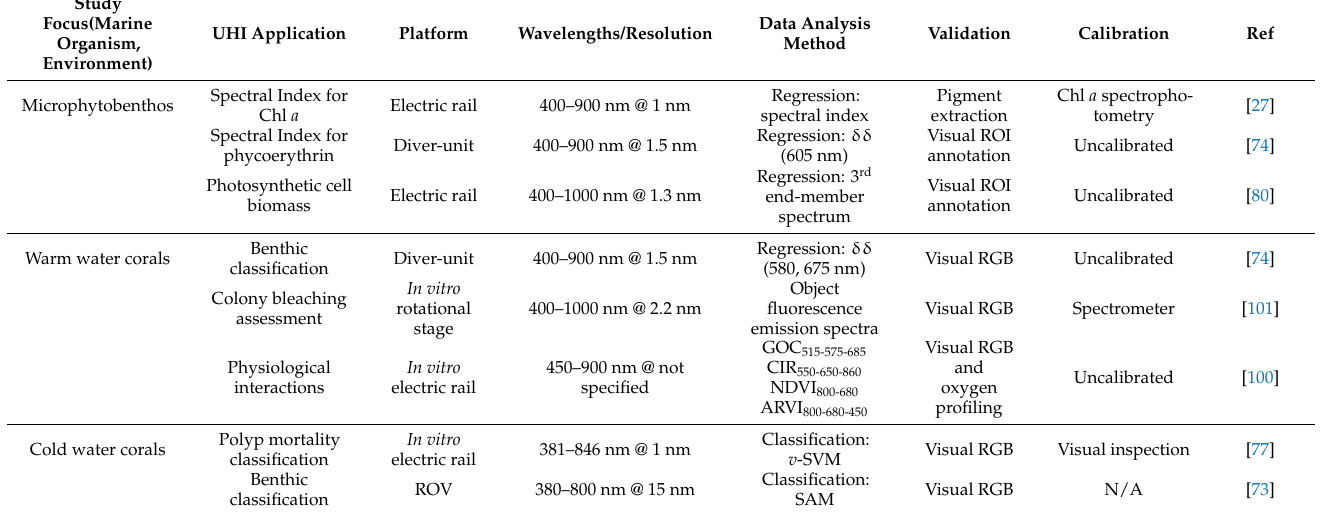
Table 2. Underwater hyperspectral imaging (UHI) studies of marine benthic habitats and organisms. Validation refers to the technique employed to authenticate UHI imagery to other standard methodologies. Calibration refers to the technique employed to derive a classification or regression that can be applied to UHI